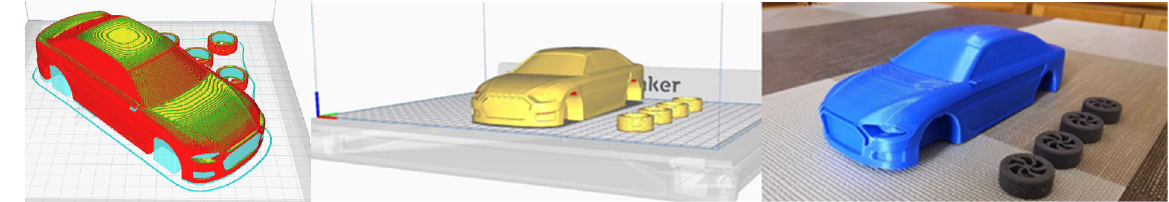
Figure 9. 3D printing of the 3D model car.